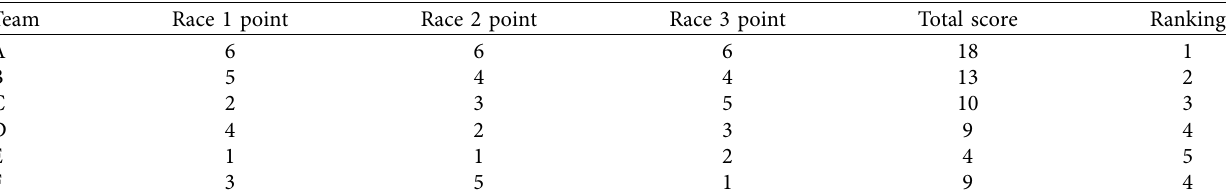
Table 1: Score ranking from first 3 races.